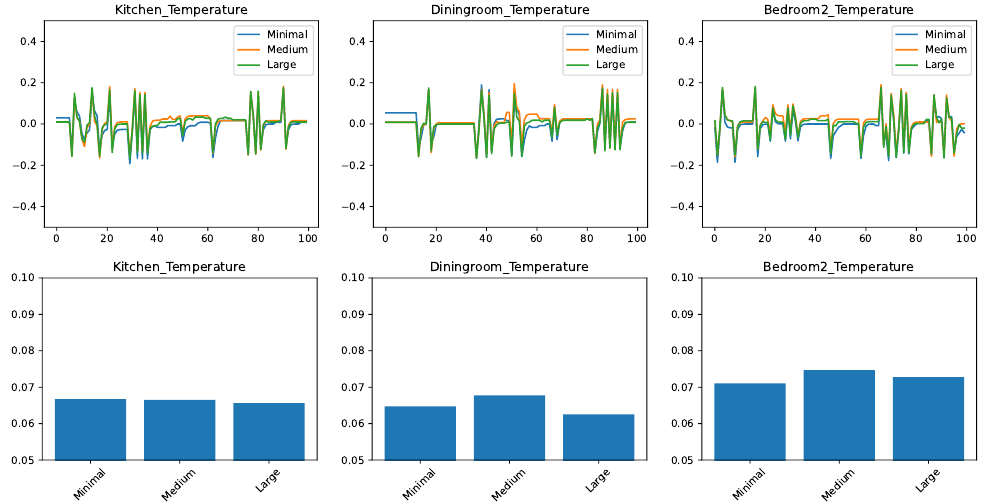
Figure 6. Comparing the prediction of a k -nearest neighbor regressor with k = 20 for different feature sets. ( top ) Prediction error in time. ( bottom ) RMSE over the test